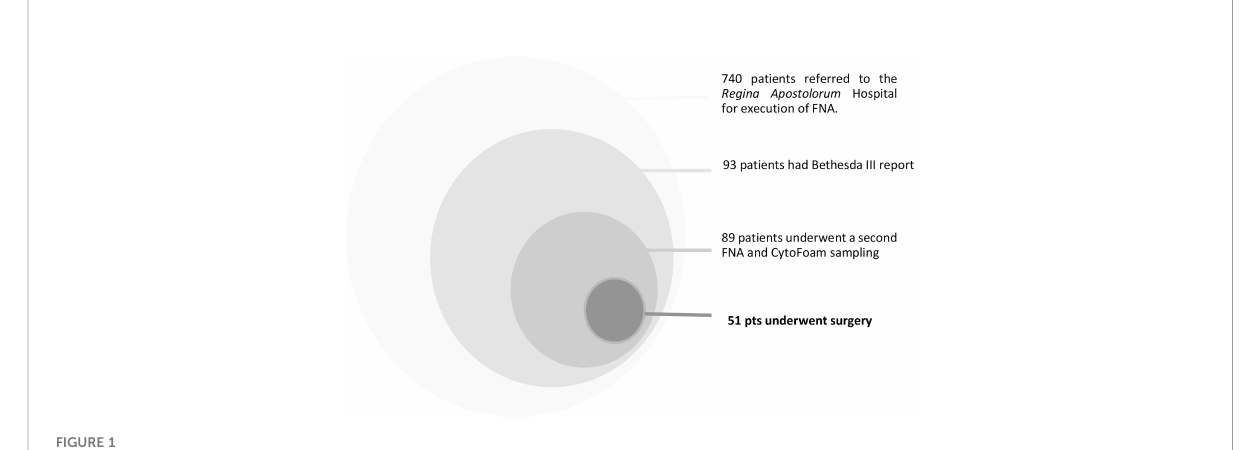
FIGURE 1 Patients